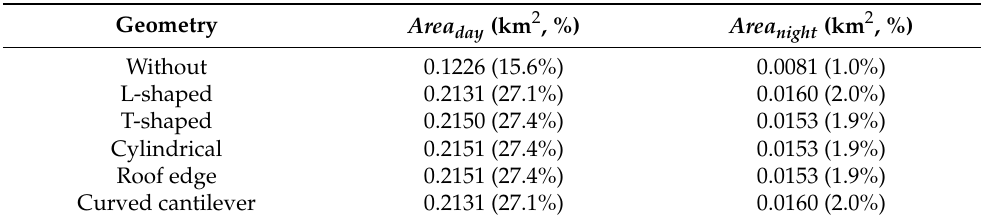
Table 3. Area of the University Town that was covered by different sound pressure levels in the daytime (<60 dBA) and nighttime (<50 dBA) for the cases with and without noise barriers. Note that Area day or Area night the percentage is defined as